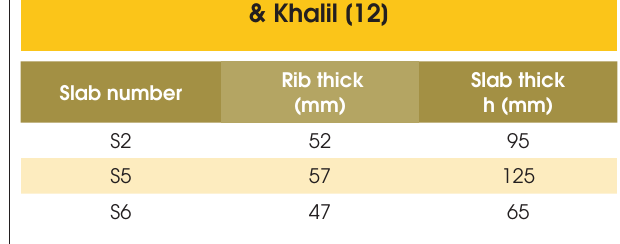
Table 2 – Slab dimensions of Abdul